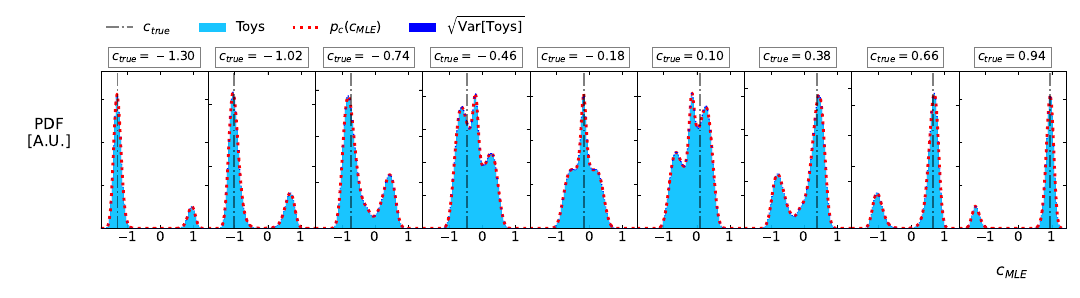
Figure 28: Distribution of c